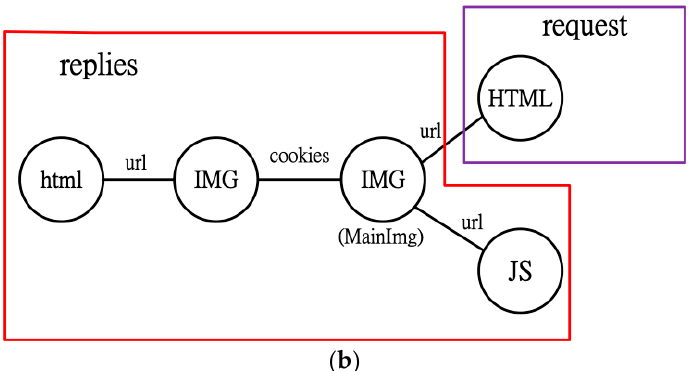
Figure 3. Graph construction of PChome ad lib: ( a ) online advertising behavior and ( b ) graph representation.